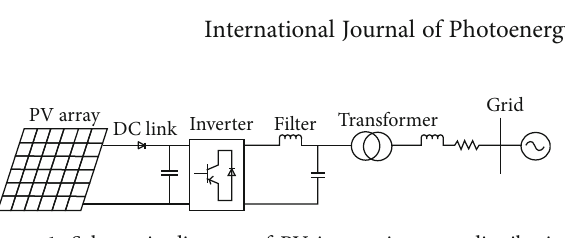
Figure 1: Schematic diagram of PV integration to a distribution system